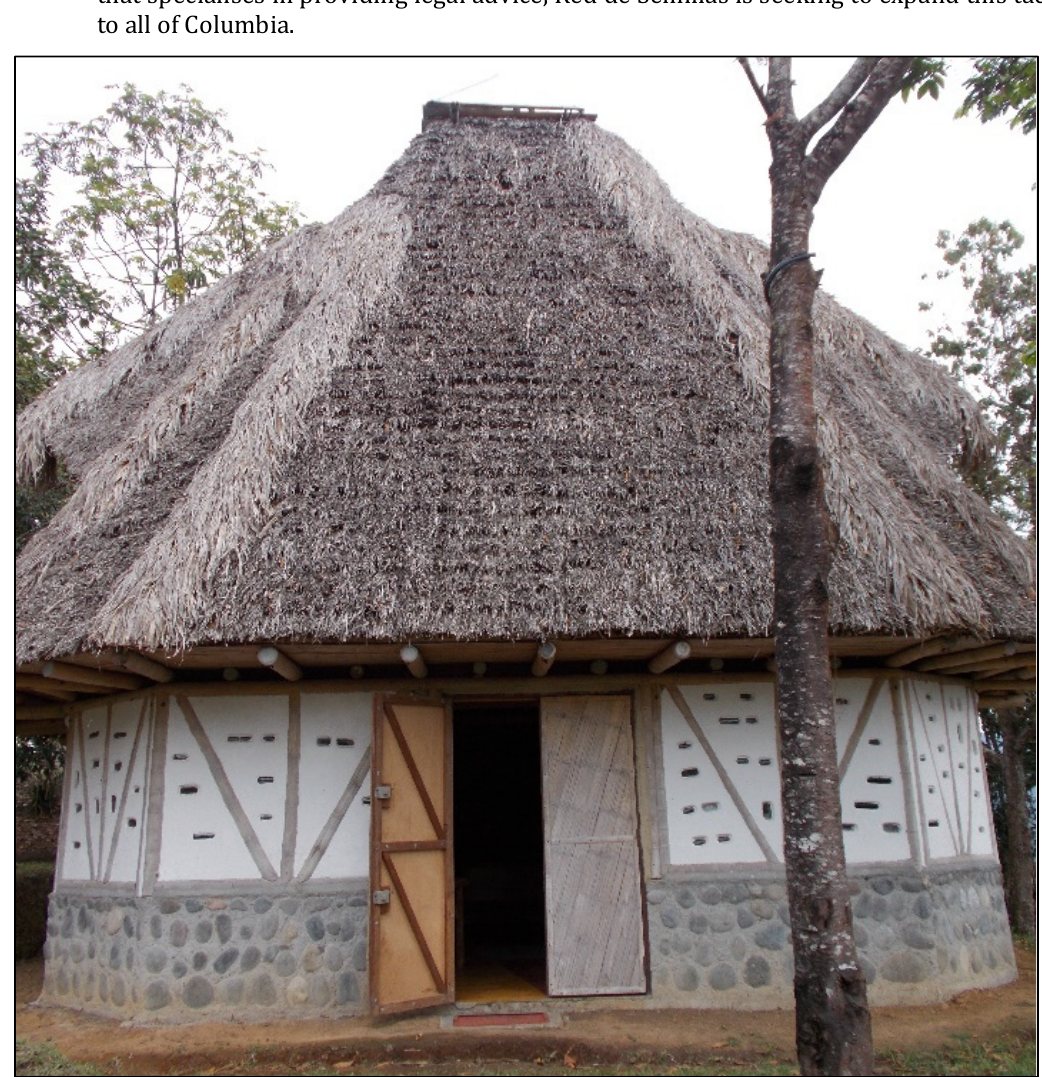
Figure 2: A casa de